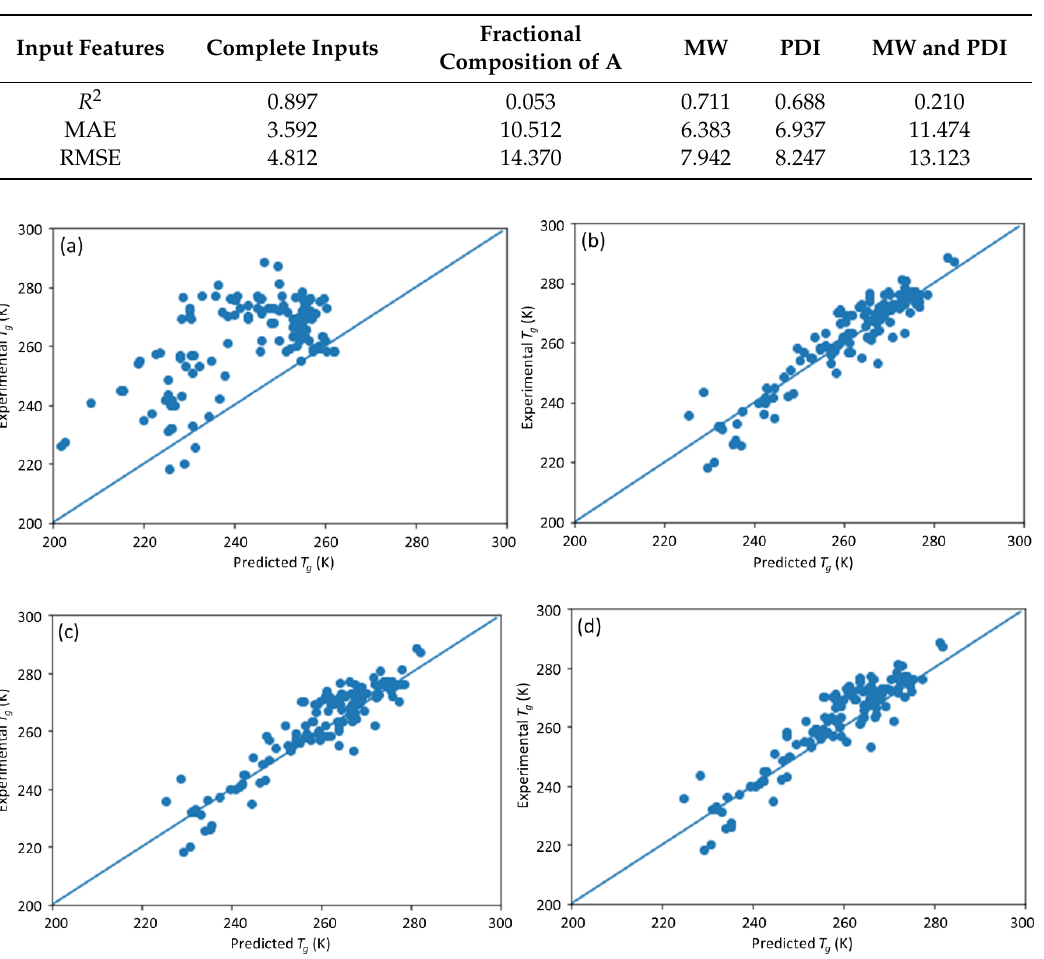
Table 7. The R 2 , MAE, and RMSE with DNN model prediction when di ff erent input variables are estimated with their maximum values.